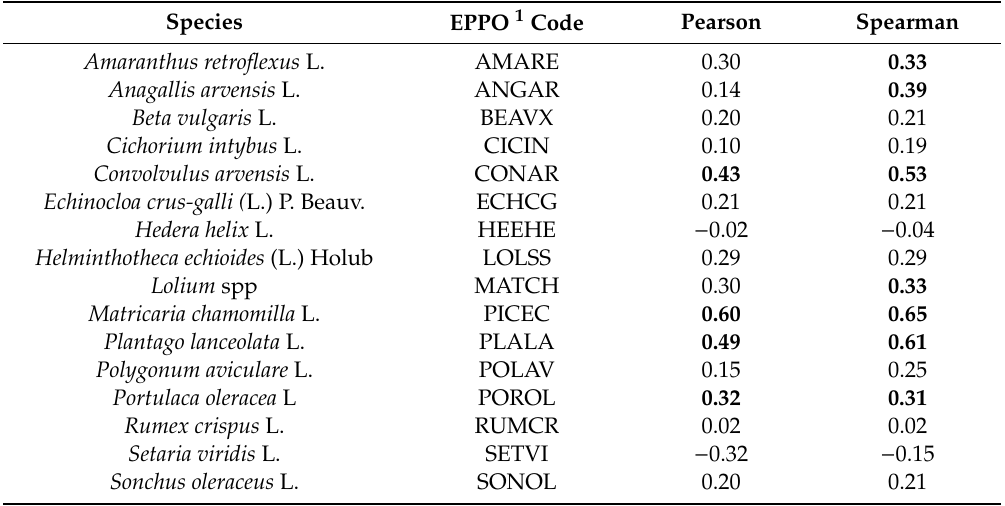
Table 4. Pearson and Spearman correlation coefficients between weed frequency and Shannon H’ diversity index (bold indicates significant coefficients at p < 0.05 after Bonferroni’s correction for multiple comparisons).